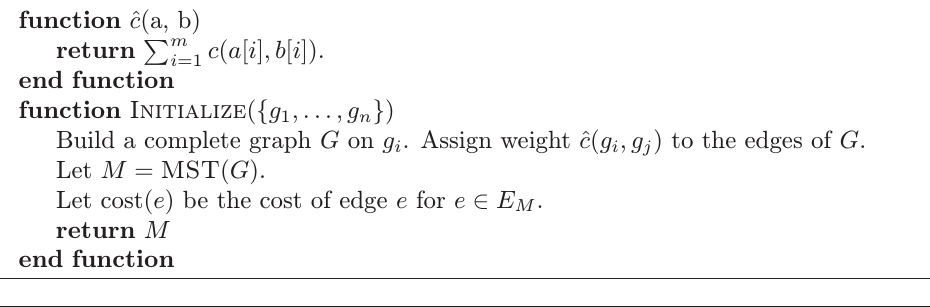
Algorithm 2 Initialize function (part of the Scelestial algorithm)